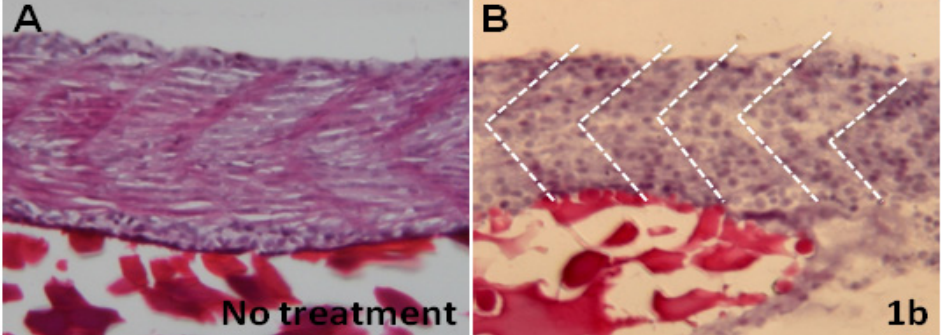
Figure 4. Compound 1b affects myofibril alignment. Representative images of hemetoxylin (H) & eosin Y (E) staining of zebrafish embryo after exposure to water ( A ) or water containing 3 ppm of compound 1b . ( B ) Dashed lines mark the boundary of somites.